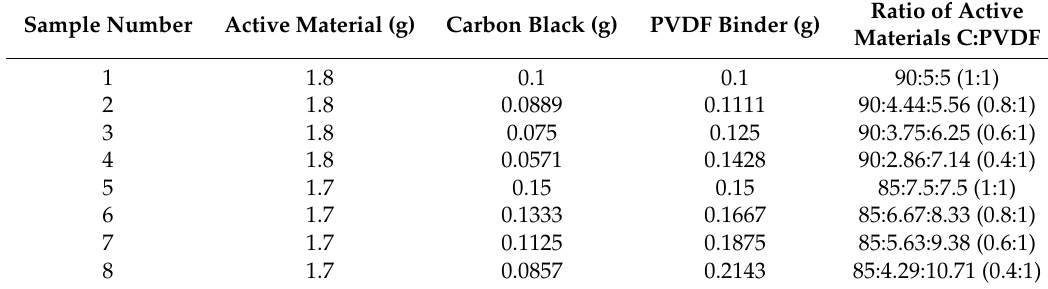
Table 1. Cathode electrode sample ratios of active material, carbon black (C) and